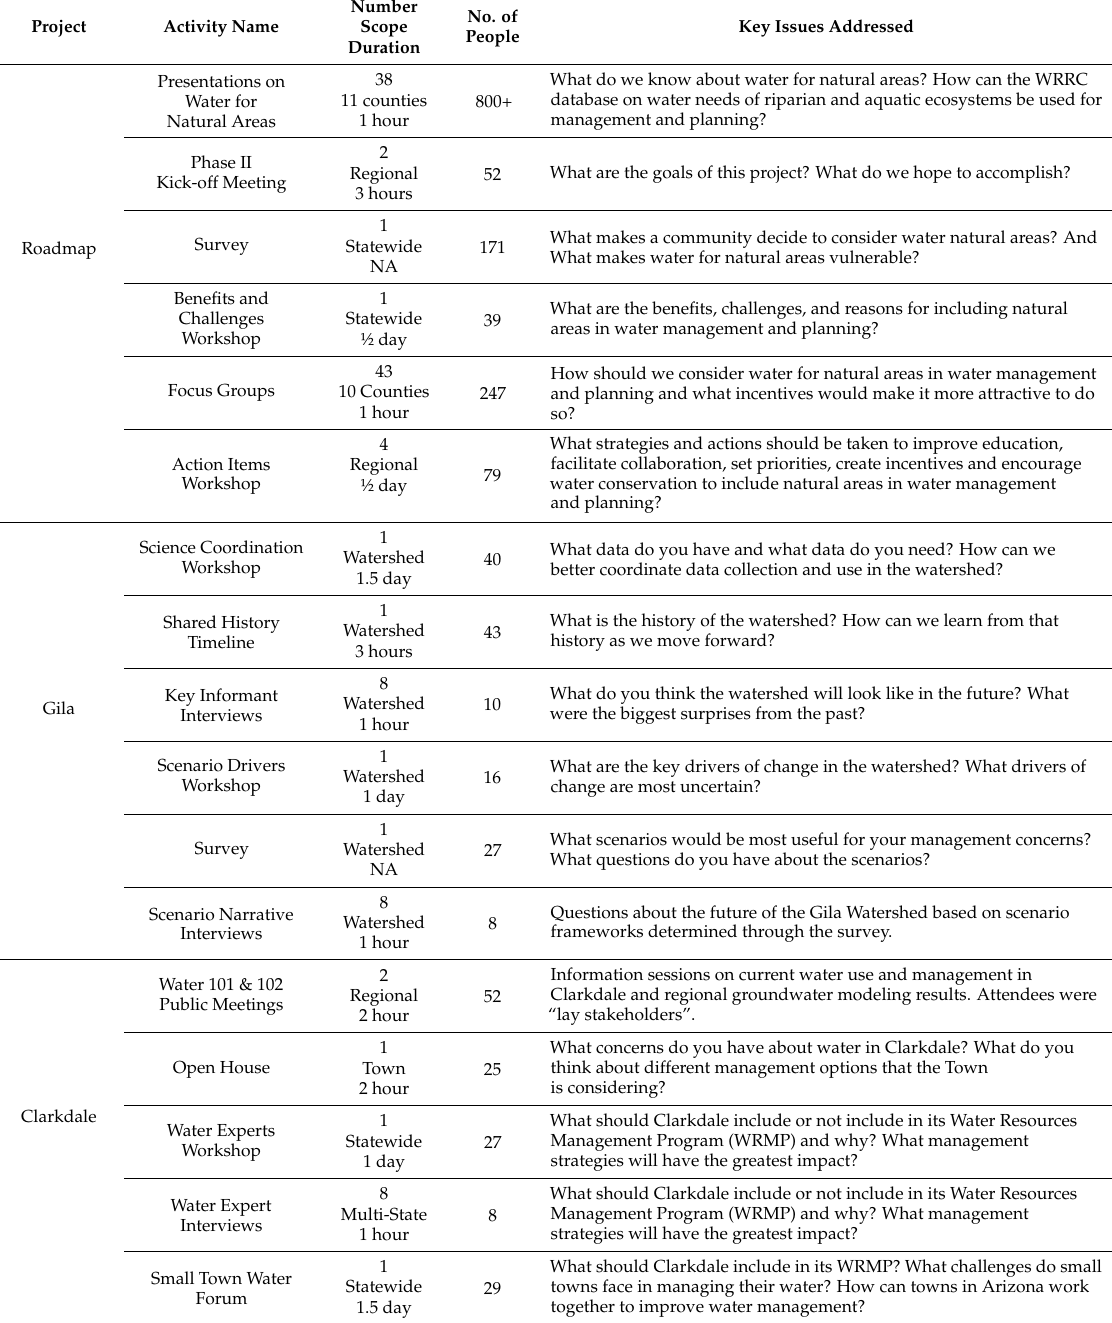
Table 1. Engagement and outreach